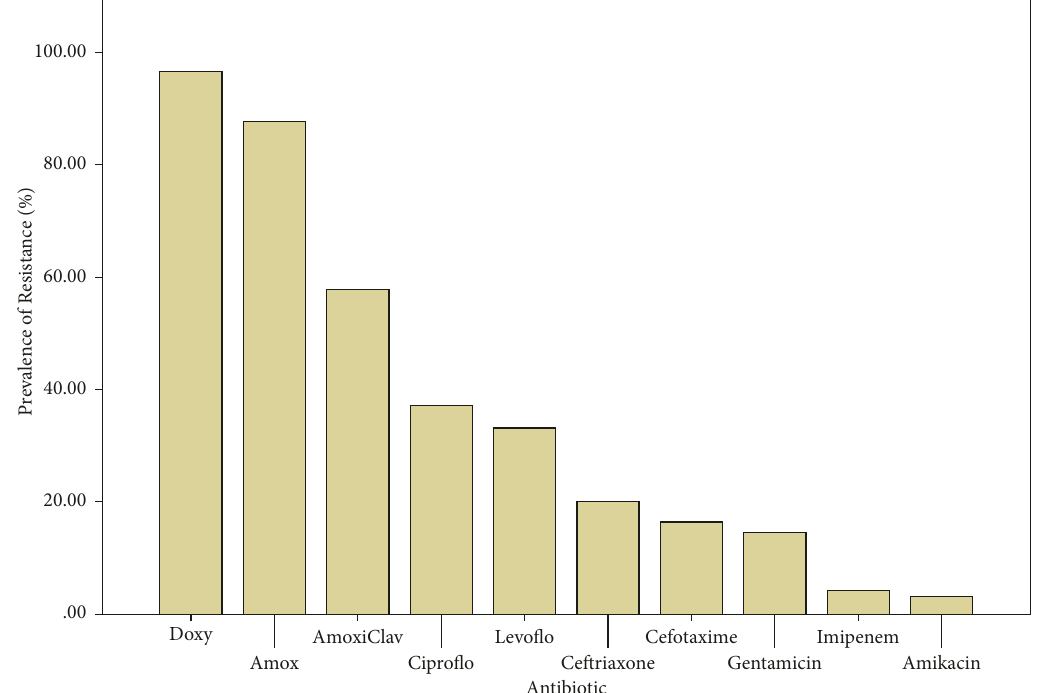
Figure 4: General prevalence of resistance of isolates to various antibiotics tested.